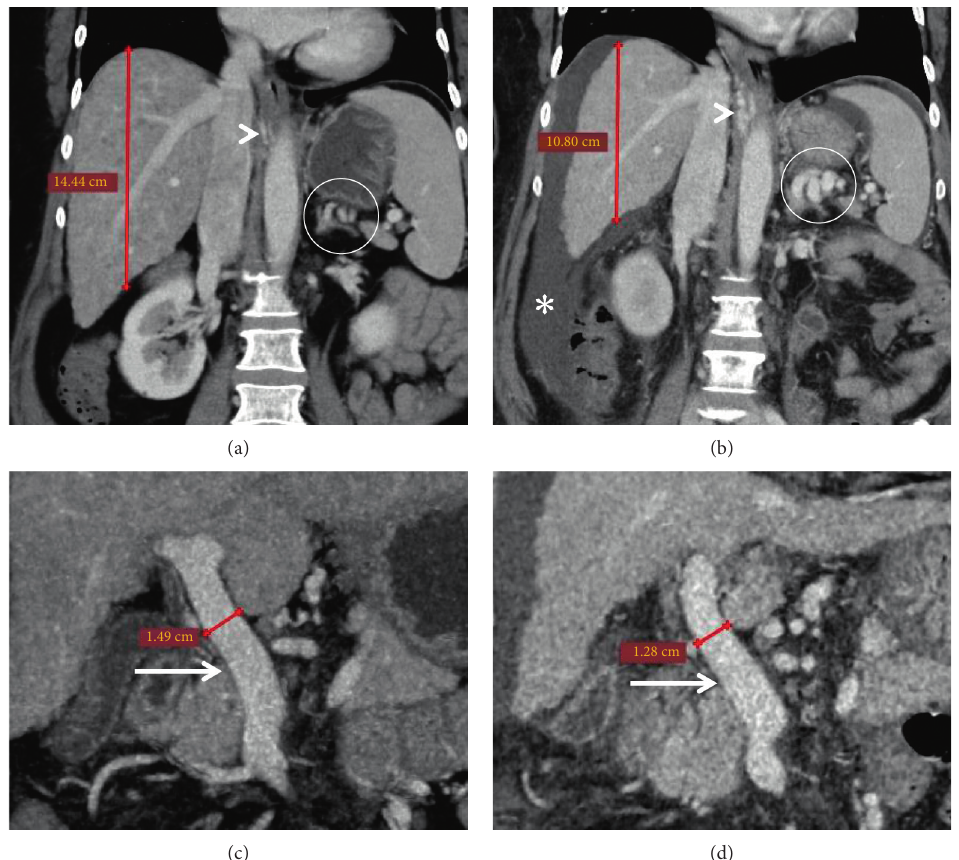
Figure 8: Coronal (a, b) and axial (c, d) CECTimages of a patient taken 1 year apart demonstrate atrophy of liver (calipers in (a, b)), decrease in the caliber of main portal vein (arrows in (c, d)), interval development of ascites (asterisk in (b)), and esophageal and paraesophageal collaterals (arrowheads) with enlargement of the splenorenal shunt